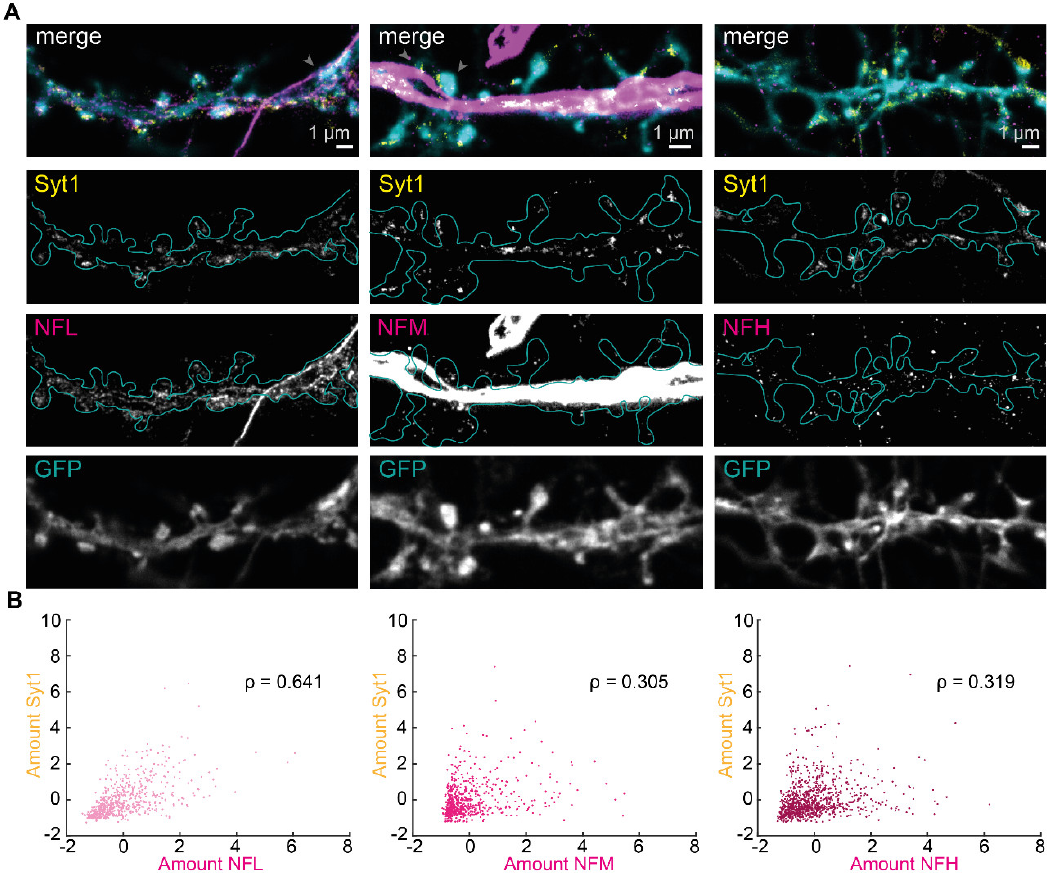
Figure 4. NFL at the postsynapse correlates with synaptic activity. ( A ) Representative dual-color STED images of neurons with Syt1 (yellow), NFs (magenta), and volume labeling (confocal, cyan) with NFL (left), NFM (middle), or NFH (right). Cyan outline represents spine shapes on the dendrite as determined by volume labeling. Scale bars are 1 µm. Only signal above the 4-counts threshold used for data analysis is shown. Gray arrows in merge images point at examples of spines that were not considered for the analysis due to the overlay of strong axonal signal. ( B ) Correlation scatterplot of NF protein amount and amount of labeled Syt1 ( area × mean intensity ). ρ indicates Spearman’s correlation coefficient with p values for NFL: 2.55 × 10 −75 ; NFM: 2.23 × 10 −15 , and NFH: 1.26 × 10 −23 . Data was obtained from 2398 manually segmented spines (686, 779, and 933 for NFL, NFM and NFH, respectively) from 16–18 images and 3 independent neuronal cultures (22–25 DIV), standardized to the mean of each experiment. Amounts represent arbitrary units.